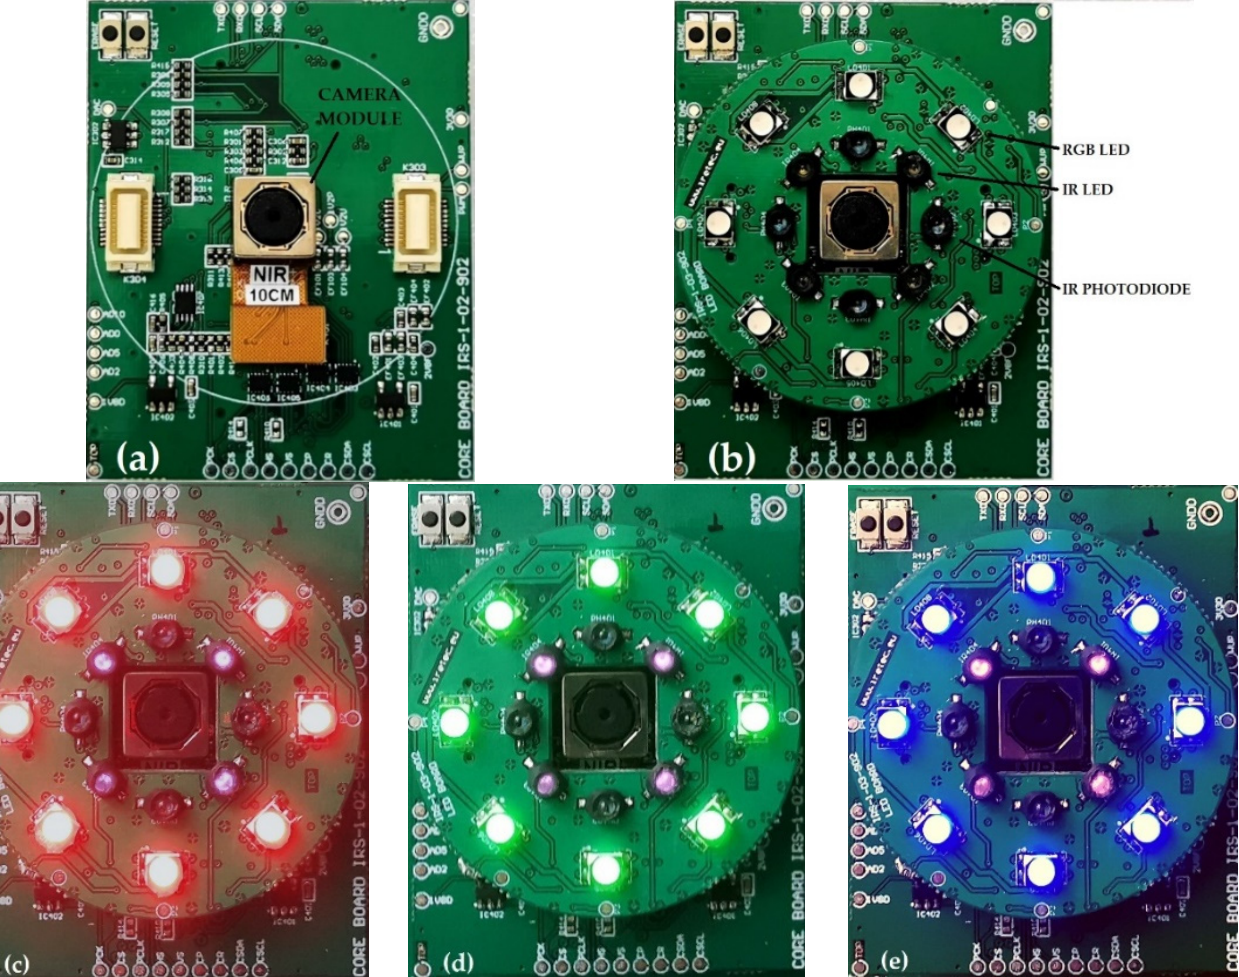
Figure 8. Image acquisition electronics: ( a ) camera module mounted on the MCU PCB; ( b ) IR distance/RGB illumination PCB mounted on the MCU PCB; ( c ) red RGB LED turned on; ( d ) green RGB LED turned on; ( e ) blue RGB LED turned on.